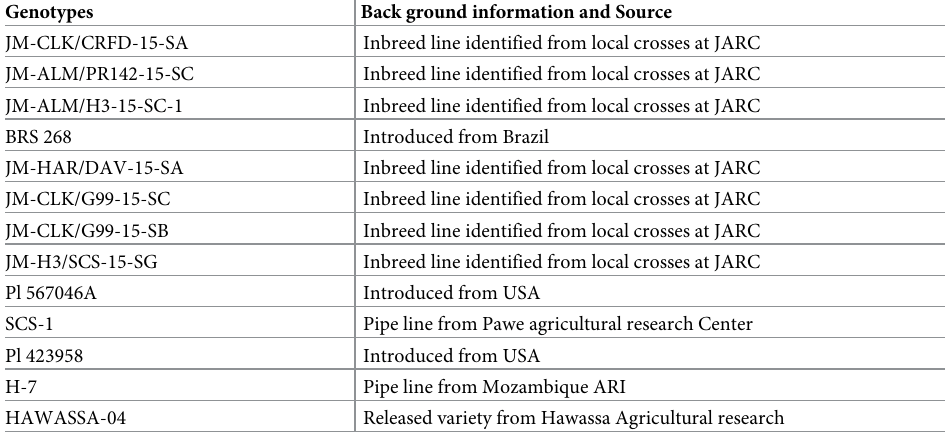
Table 2. Soybean genotypes used for the